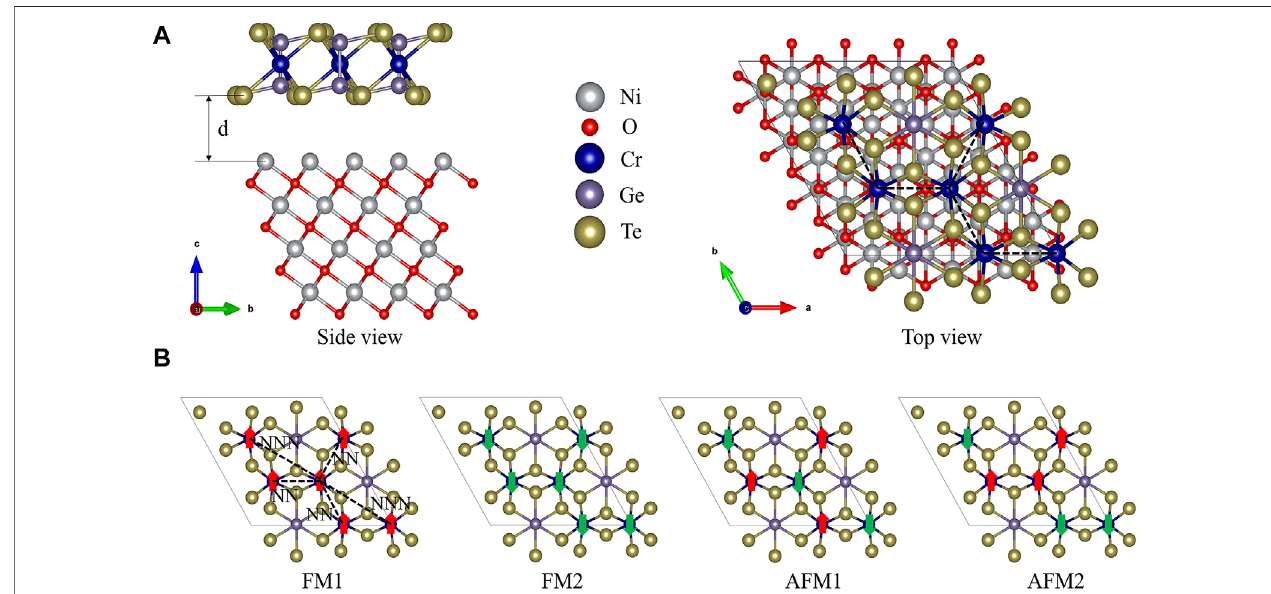
FIGURE 1 | (A) Top and side views of the CrGeTe 3 /NiO heterostructure. (B) Four possible magnetic states of CrGeTe 3 : FM1, FM2, AFM1, and AFM2.